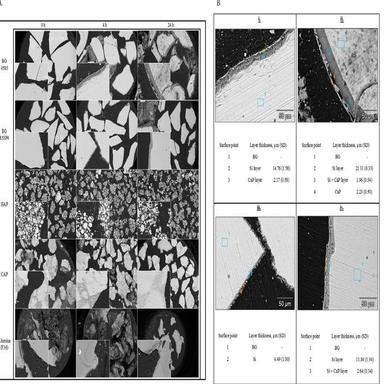
(a) SEM images of the cross-sectional surfaces of the studied materials after dissolution in continuous flow of in the Tris-buffer solution for up to 24 h at 50x and 500x (left bottom corner) magnification, the width and length of the image being 2.4 × 1.8 mm and 240 × 180 mm, respectively. (b) SEM micrographs showing the reaction layer thicknesses for BG 45S5 after 4 h (i) and 24 h (ii) and for BG S53P4 after 4 h (iii) and 24 h (iv). The EDX analyses give the elemental compositions of bulk glasses (points